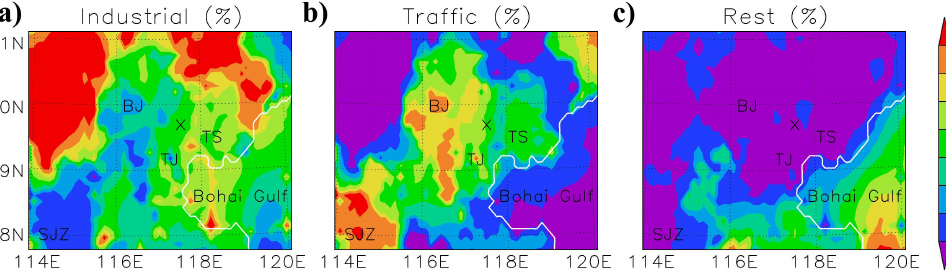
Fig. 4. Percentage contributions from industrial, traffic and other sources to the NO x in the PBL as estimated with a tracer-tagging method in our RCTM. Labels are the same as in Fig.